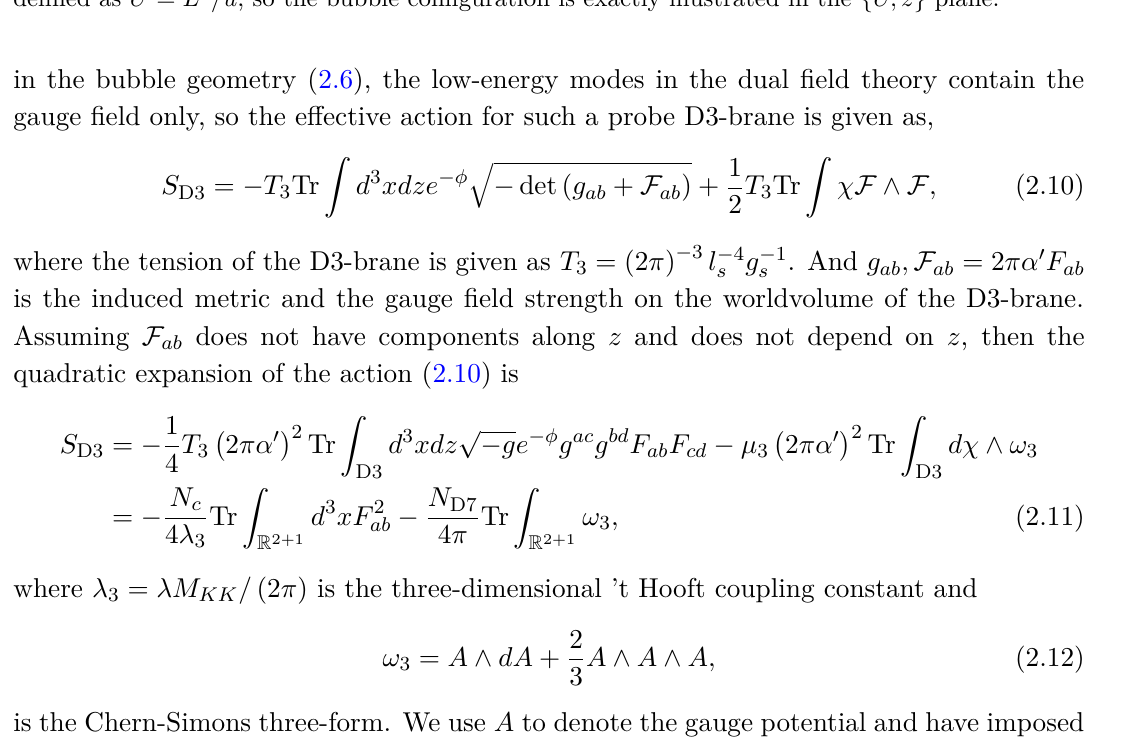
Figure 1 . The bubble geometry of the N c D3-brane. The bulk ends at u = u KK and the holographic boundary is located at u = 0 . We note that the standard holographic radius coordinate is in fact defined as U = L 2 /u , so the bubble configuration is exactly illustrated in the { U, z }